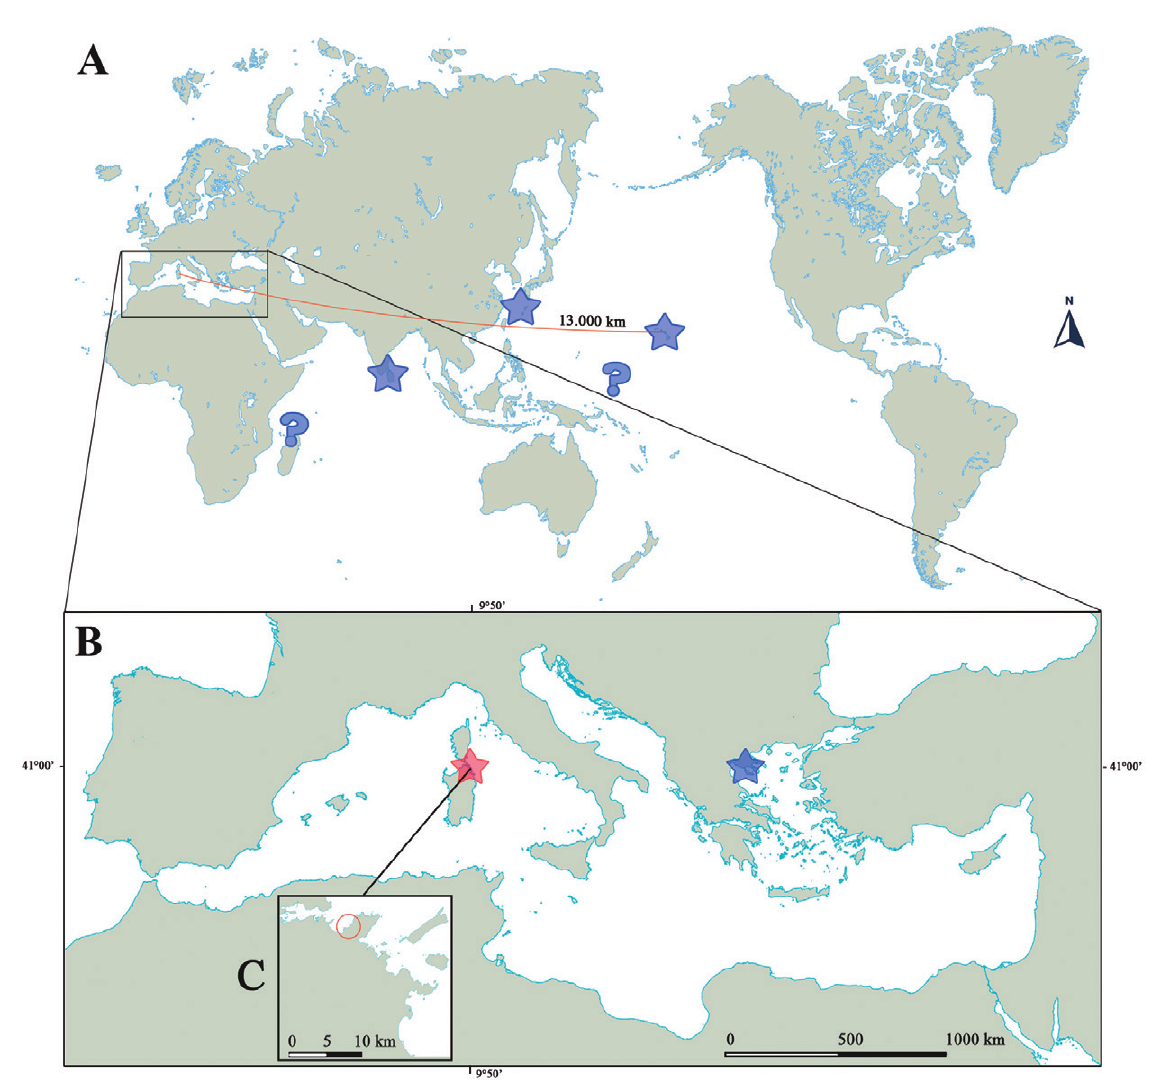
Figure 1. Map showing ( A ) Indo-Pacific records of Elysia nealae (blue stars = records from literature; blue question marks = uncertain records from websites), ( B ) Mediterranean records of Elysia nealae (red star = record in this study), and ( C ) study area in the northeastern Sardinia and, circled in red, the locality of the record reported